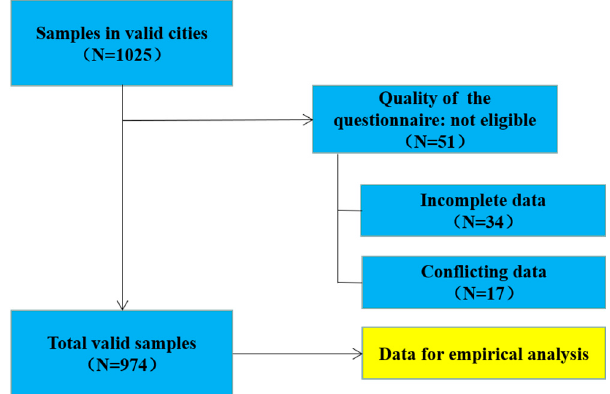
Figure 3. Online sample screening process.